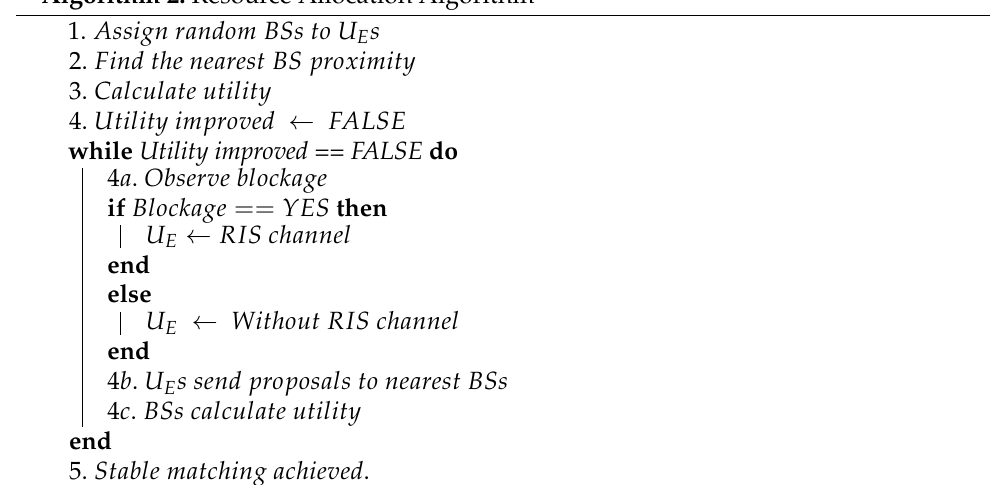
Algorithm 2: Resource Allocation Algorithm